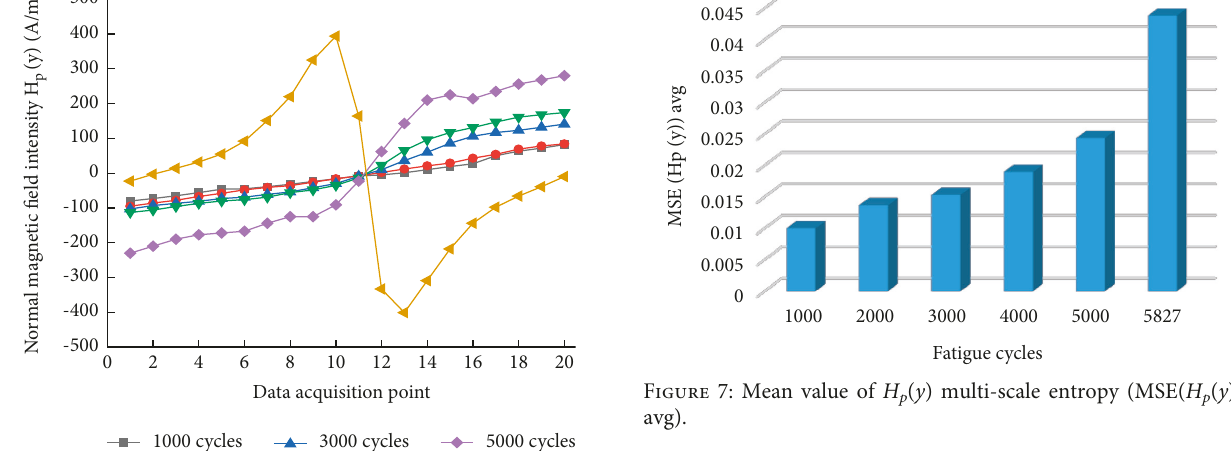
p ( y ) multi-scale entropy (MSE( H p ( y ))